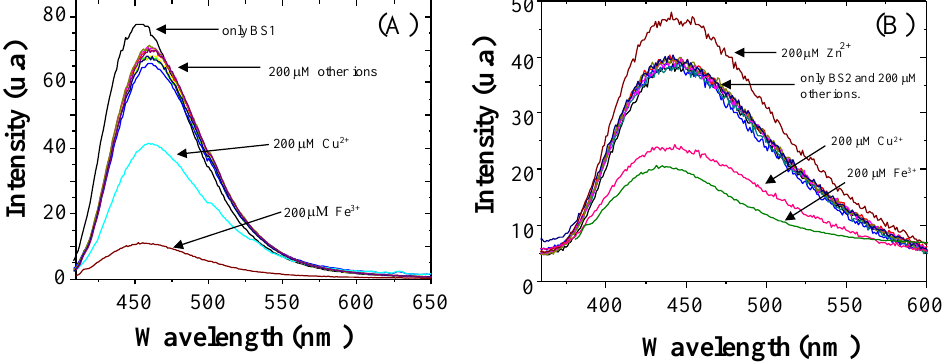
Figure 2. Change in fluorescence intensity of ( A ) BS1 (2 μM) and ( B ) BS2 (2 μM) upon addition of various metal ions (200 μM) (Fe 2+ , Fe 3+ , Ca 2+ , Co 2+ , Mg 2+ , Mn 2+ , Zn 2+ , Cd 2+ , Pb 2+ and Hg 2+